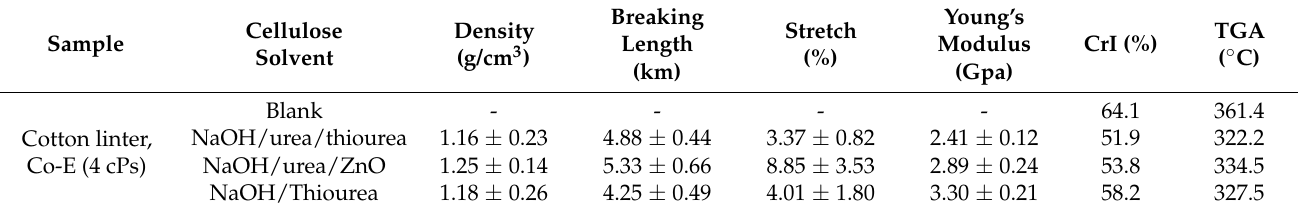
Table 3. Physical properties of films prepared by alkaline cellulose solvents.